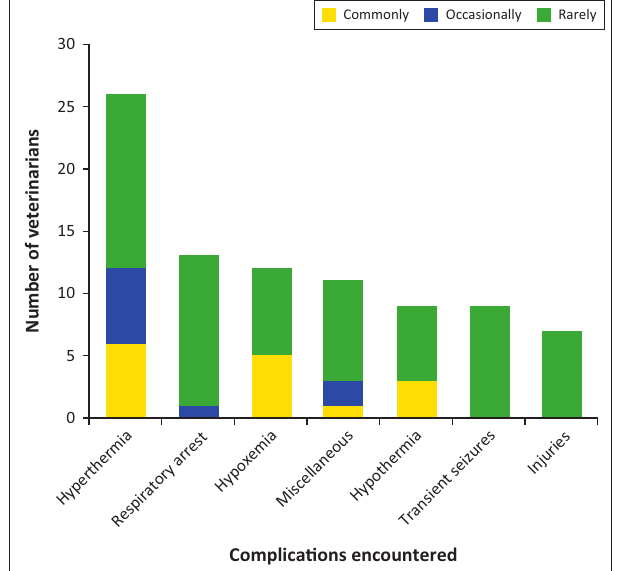
FIGURE 2: Stacked bars showing the number of veterinarians who had experienced various complications, and the perceived frequency of such events, during the capture and anaesthesia of cheetahs in their careers. Commonly = perceived to occur in > 50 % of captures; Occasionally = perceived to occur in between 25 % and 50 % of captures; Rarely = perceived to occur in < 25 % of